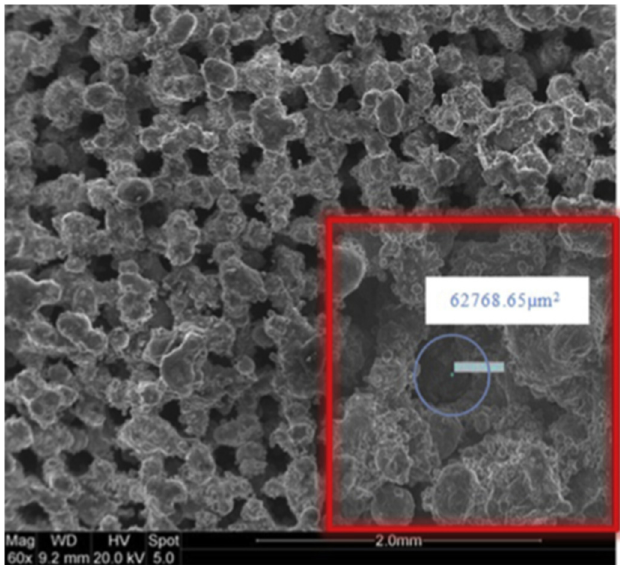
Figure 3. Microscopic image of AM porous structure [12].